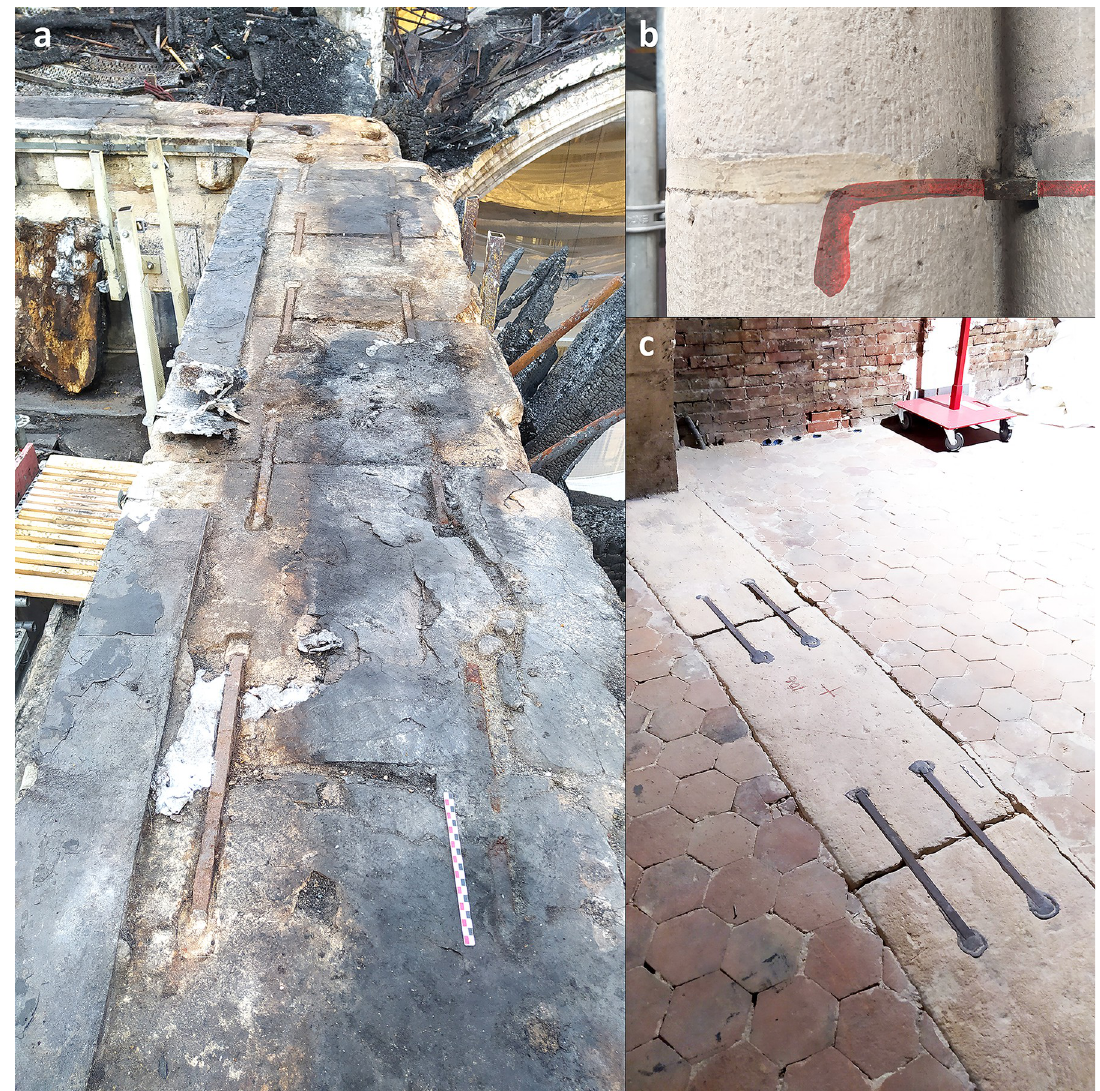
Fig 1. Iron armatures in Notre-Dame. a. Iron staples of the top walls (southern nave looking on the angle of the southern transept). b. Iron staples inside the monolithic columns of the nave (view of the staple in red). c. Iron staples in the tribunes of the choir (staples n˚ 121 to